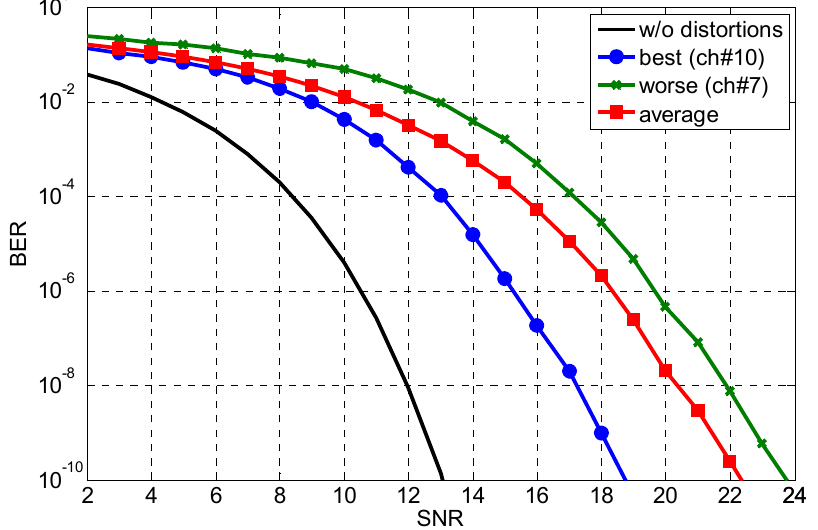
Figure 10. BER vs. SNR for transmission at 10 Gb/s of 32 NRZ-OOK channels with roundtrip loss α = 0 in presence of XT.